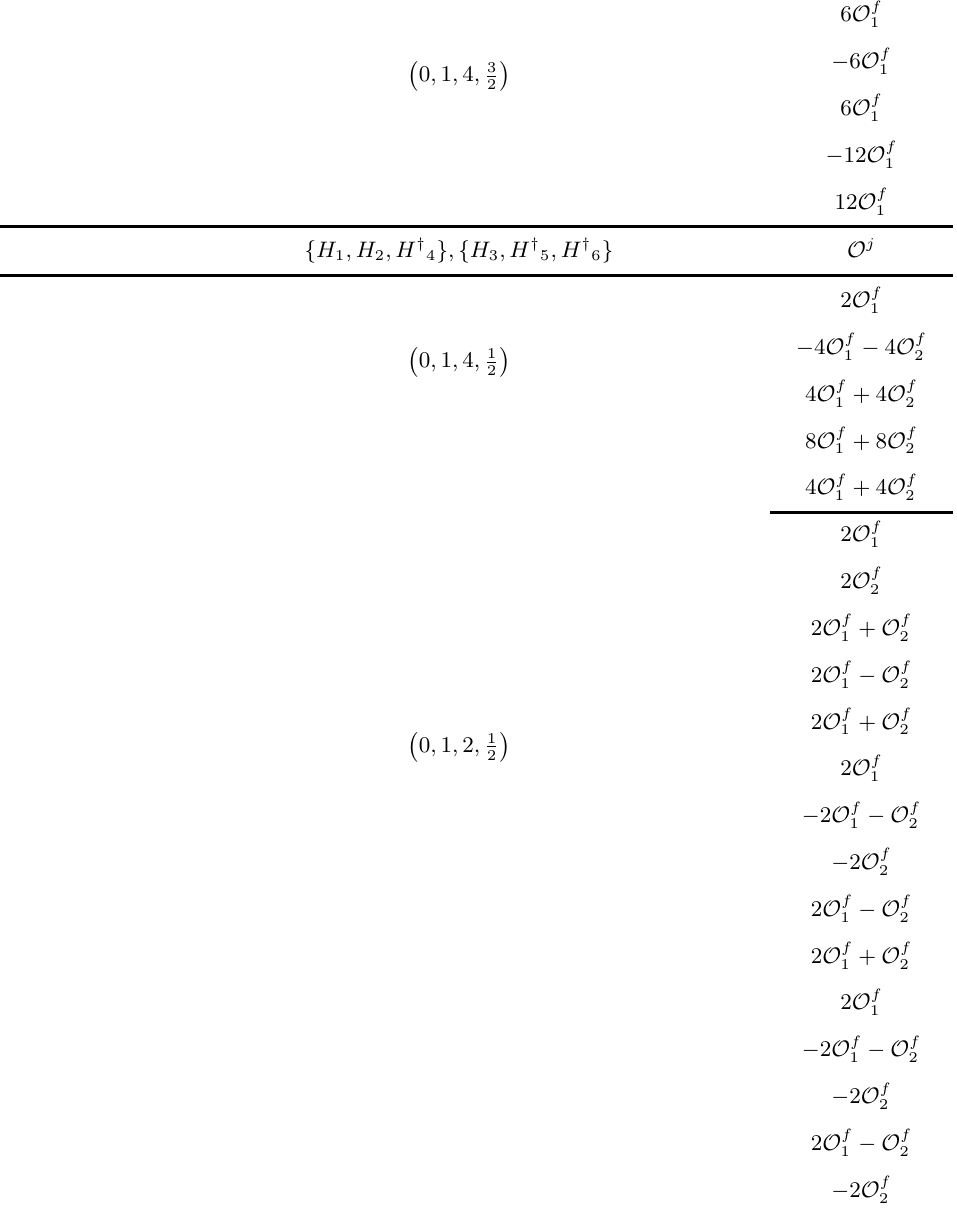
Table 30. UV resonance of topology dim8-bosonic-6. “*” in front of each row indicates topologies with nonrenormalizable